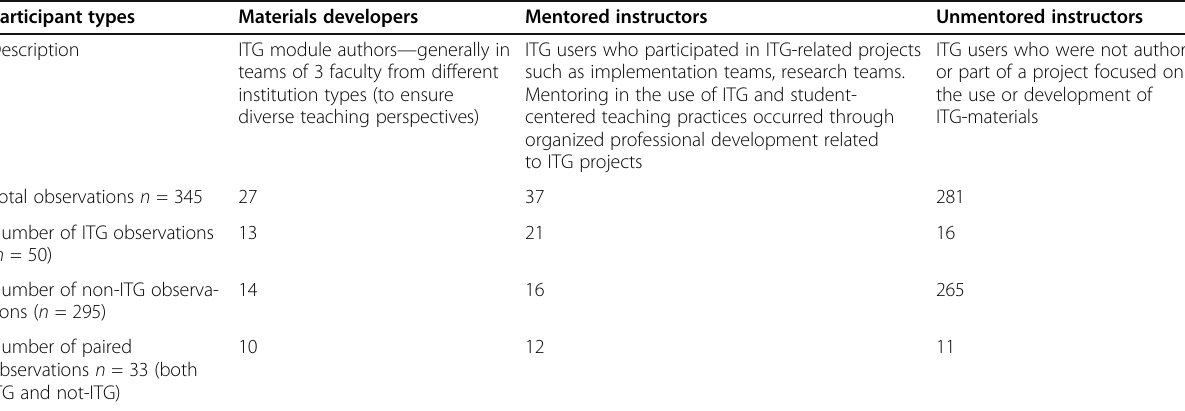
Table 3 Observations of instructors by their ITG participation category